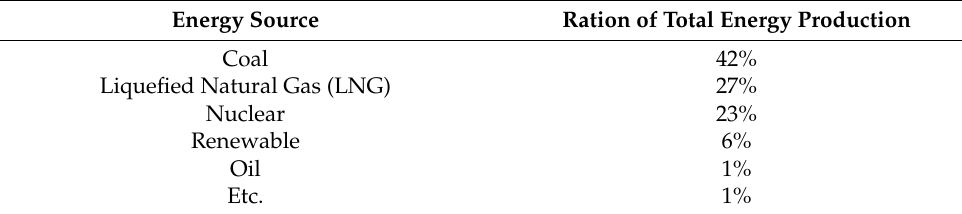
Table 7. Energy source accountability to produce electricity in Korea.